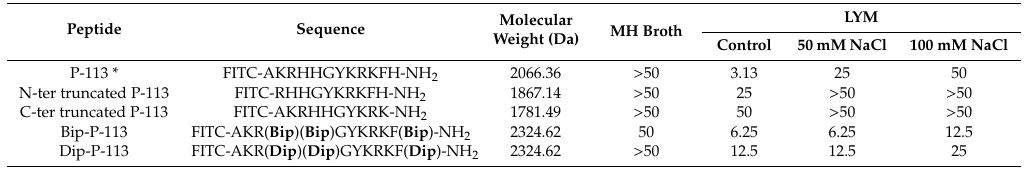
Table 1. Minimum inhibitory concentration (MIC) values of P-113 and its derivatives against C. albicans American Type Culture Collection (ATCC) 10231 (µg/mL).